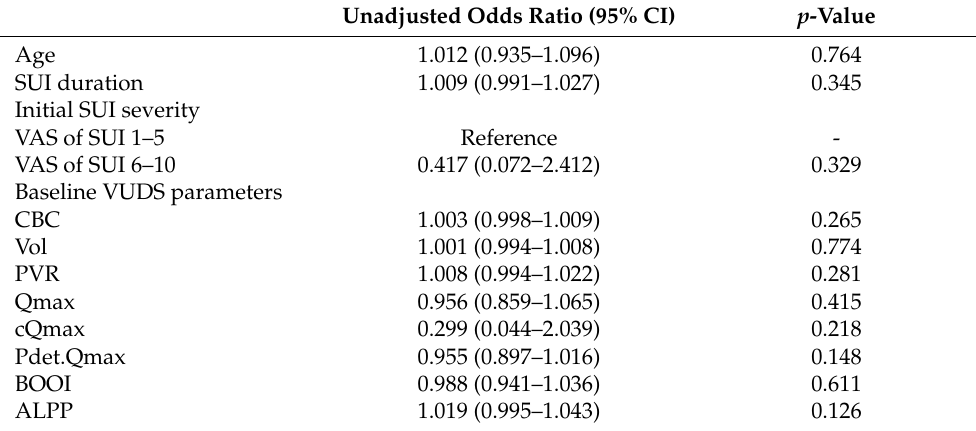
Figure 1. Changes in stress urinary incontinence (SUI) severity in accordance with the visual analog scale of SUI after autologous platelet-rich plasma urethral sphincter injections ( A ) in all patients; ( B ) subgroup analysis by outcome. Note: 1. Data are presented as the mean and standard error of the mean (SEM). 2. Patient dropped out after receiving further anti-incontinence treatment. 3. Abbreviation: FU = follow-up. * p value < 0.05 (compared with baseline). Table 3. Logistic regression analysis for predictors of successful